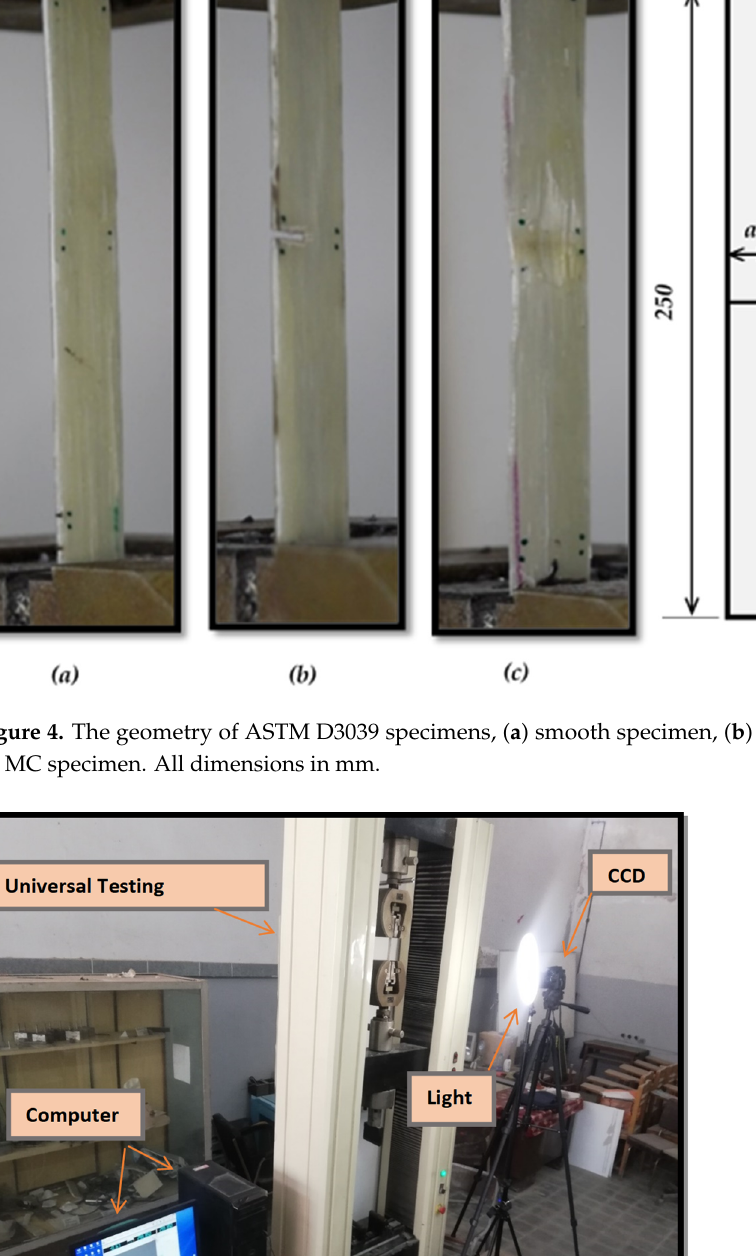
Figure 3. The geometry of ASTM E1922 specimens, ( a ) smooth specimen, and ( b ) TTC Specimen. All dimensions in mm.